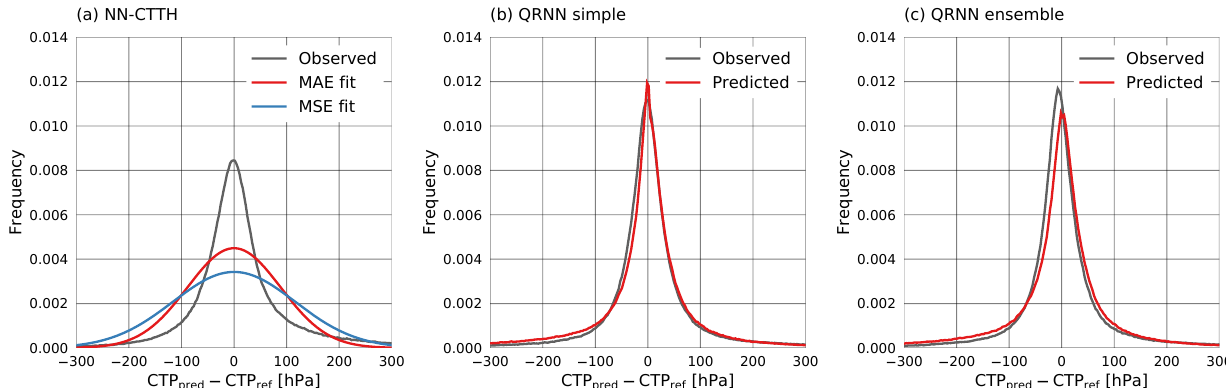
Figure 11. Predicted and observed error distributions. Panel (a) displays the observed error for the NN-CTTH retrieval as well as the Gaussian error distributions that have been fitted to the observed error distribution based on the MAE and MSE. Panel (b) displays the observed test set error for a single QRNN as well as the predicted error obtained as the deviation of a random sample of the predicted a posteriori distribution from the median. Panel (c) displays the same for the ensemble of